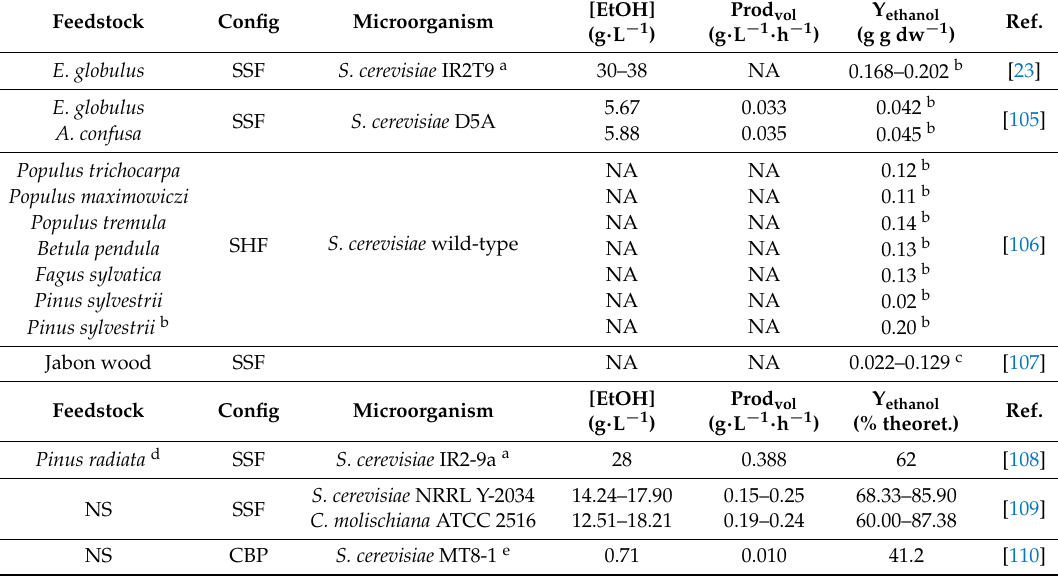
Table 3. Kraft pulp for bioethanol